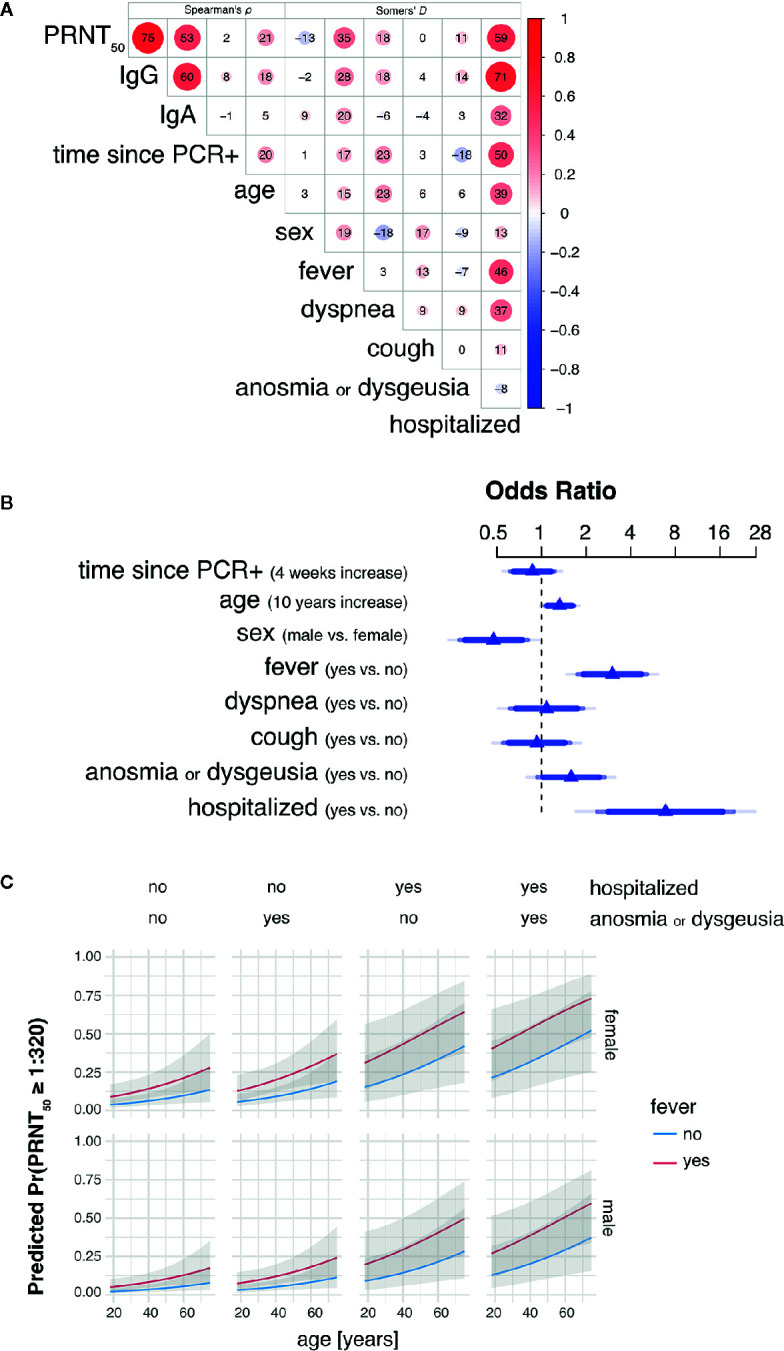
Hospitalization, fever and age are main predictors of high SARS-CoV-2 neutralizing antibody titers in convalescent plasma. (A) Heat plot representation summarizing bivariate rank correlation coefficients between all variables analyzed. Shown is only the upper triangle of the correlation matrix where correlation coefficients are given as Spearman’s ρ for continuous variables (four leftmost columns) and Somers’ D for bivariate correlations including at least one binary variable. Positive and negative correlations are colored in red and blue, respectively. Numbers within circles represent correlation coefficients expressed as percent while circle sizes are proportional to the absolute correlation coefficient values. (B) Adjusted odds ratios (OR) estimated by multivariable proportional odds (PO) logistic regression analysis are shown for each predictor of PRNT50 titer as response variable. OR of continuous variables are calculated for 4 weeks increase in time since PCR+ and 10 years increase in age. Blue of different transparencies indicates 90, 95, and 99% confidence levels. (C) Predicted probabilities for PRNT50 titers of at least 1:320 for varying predictor settings with 95% confidence bands. Shown are predicted probabilities for age ranging from 18 to 75 years in females (top row) and males (bottom row) by all possible combinations of hospitalization status with presence of anosmia or dysgeusia (columns) and fever (blue and red lines). Effects were estimated by a L2-penalized PO logistic regression model including all shown, most important variables age, sex, fever, anosmia or dysgeusia, and hospitalization.